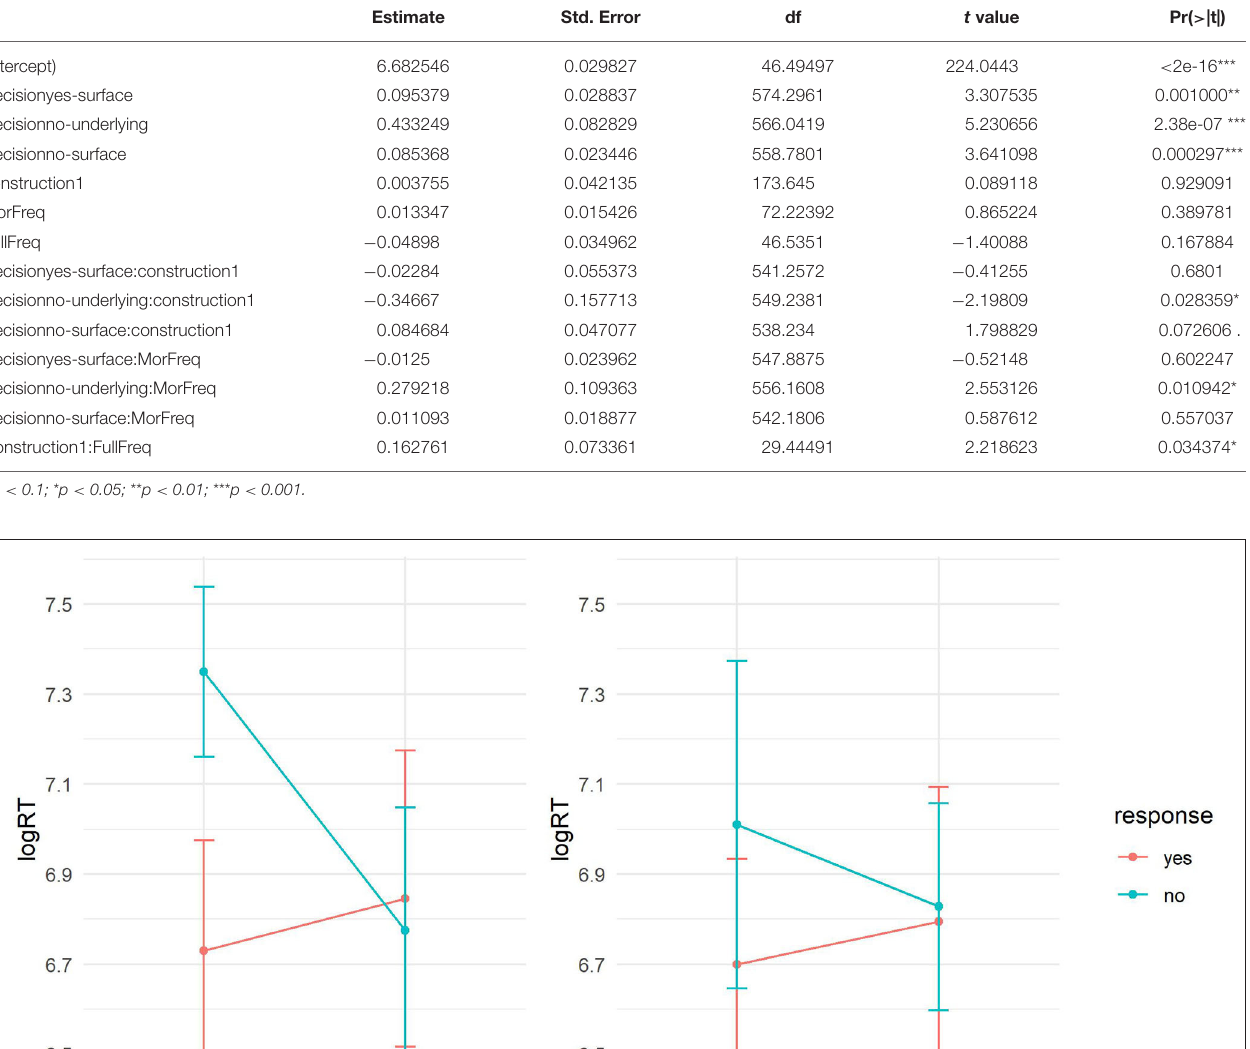
TABLE 6 | Linear mixed effects regression model: T3-RED vs. T3-COM. Estimate Std. Error df t value Pr( > |t|)